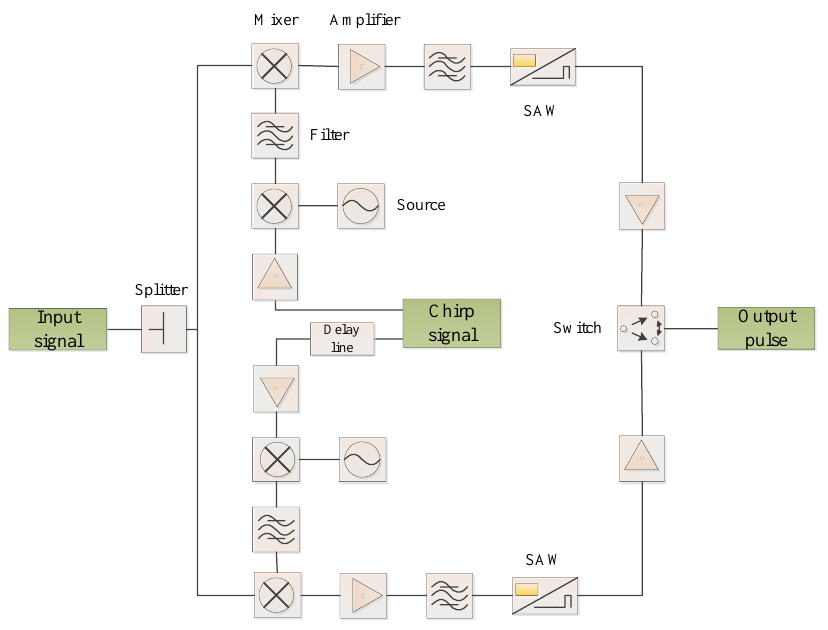
Figure 2. Classical M ( l ) − C ( s ) arrangement of the chirp transform